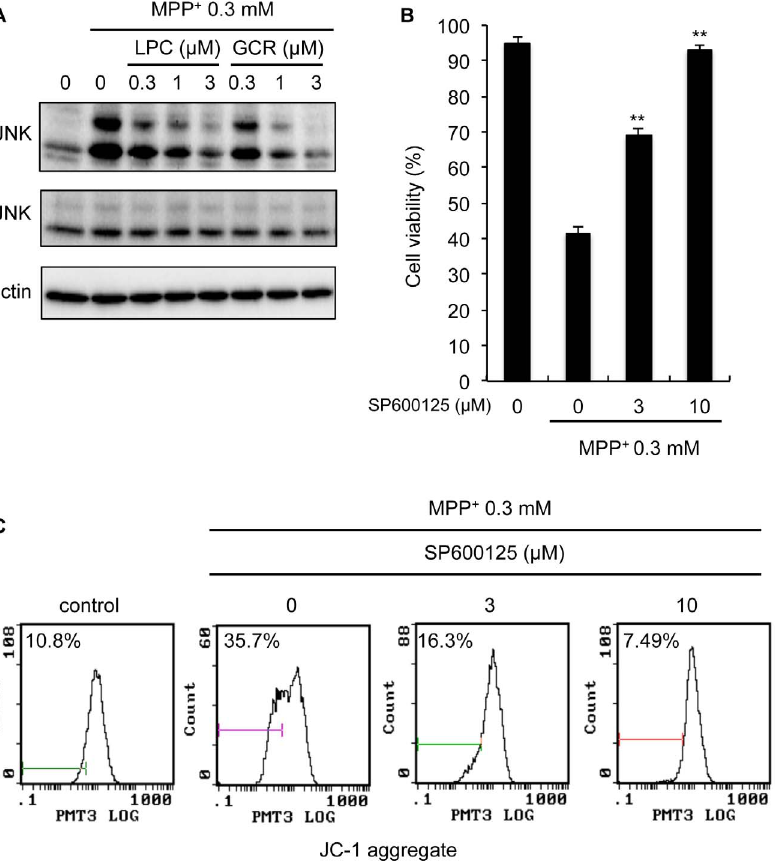
Figure 8. Licopyranocoumarin and glycyrurol attenuated MPP + -induced JNK activation. ( A ) NGF-differentiated PC12D cells were treated with various concentrations of licopyranocoumarin (LPC) or glycyrurol (GCR) and 0.3 mM MPP + for 36 h, and JNK and phosphor-JNK level were detected by Western blot. NGF-differentiated PC12D cells were treated with SP600125 and 0.3 mM MPP + for 48 h. Thereafter ( B ) cell viability was measured by trypan blue dye exclusion assay and ( C ) mitochondrial membrane potentials were assessed by JC-1 assay. Values of (B) are the means of three independent experiments; ** p , 0.01 compared with MPP + group cells.